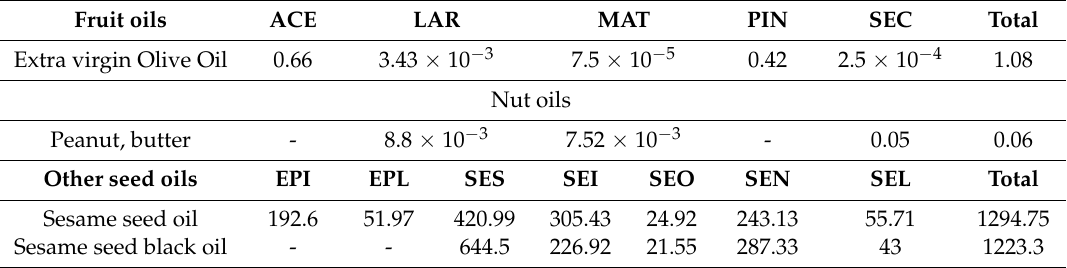
Table 8. Lignan content of oils (mg/100 g food)